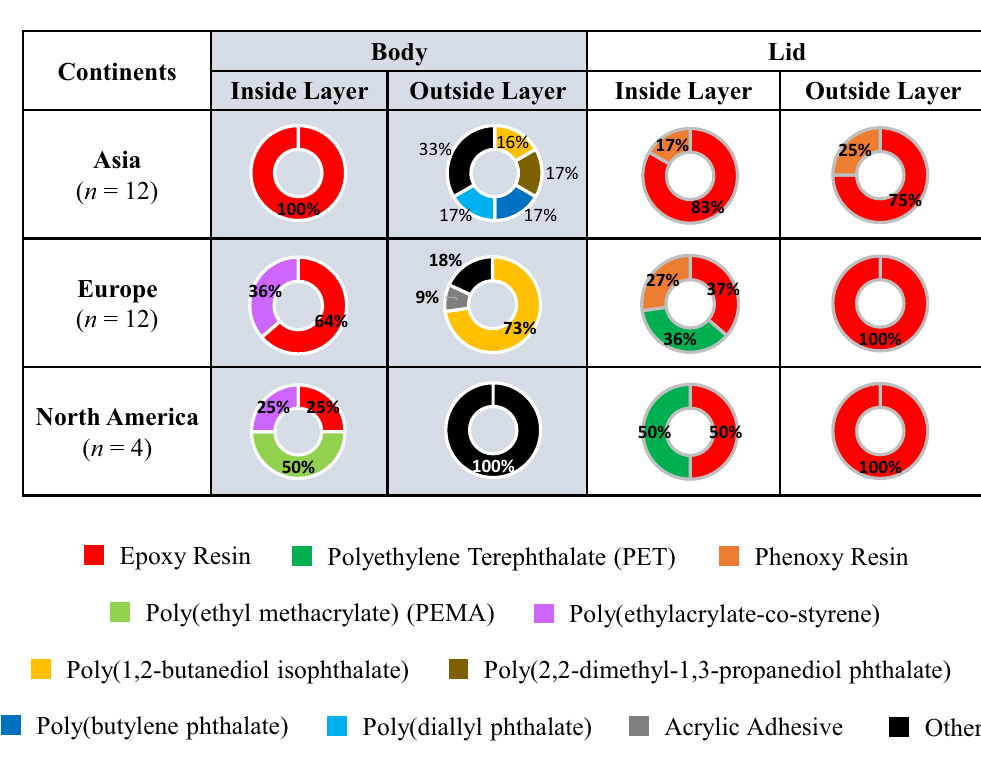
Figure 2. Compositions of polymer type in body and lid of beer